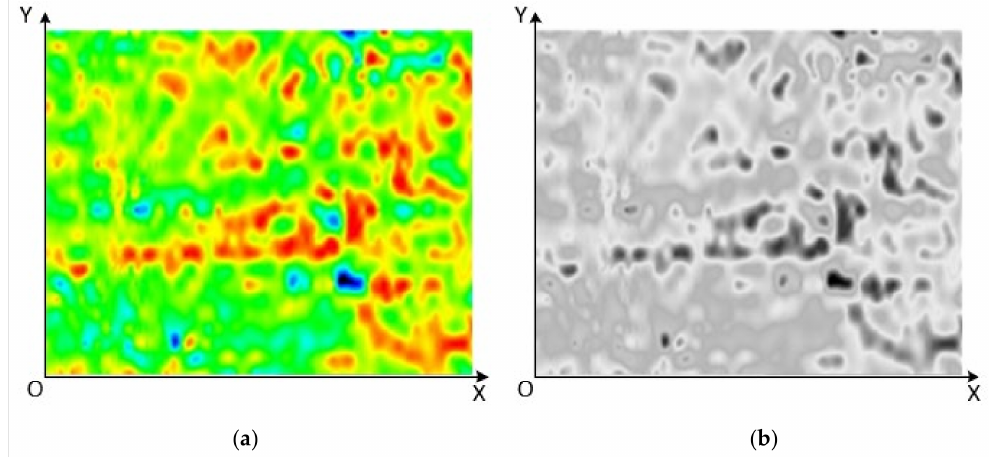
Figure 3. Examples of a horizontal section through a C-scan: ( a ) color image; ( b ) grayscale